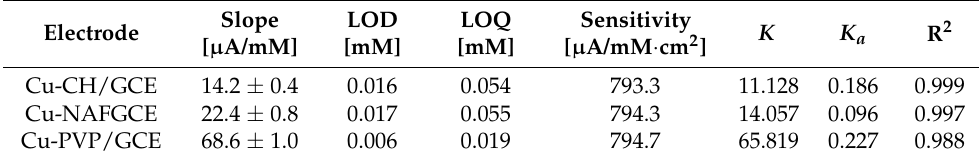
Table 3. Analytical performance of the